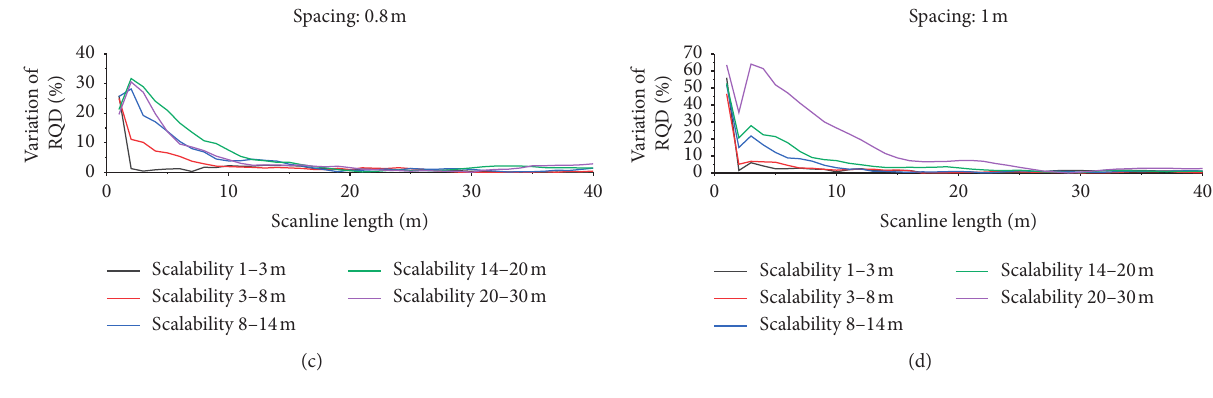
Figure 9: Variation rate of RQD values with scanline length. Table 3: Convergence scanline lengths and convergence RQD values of different